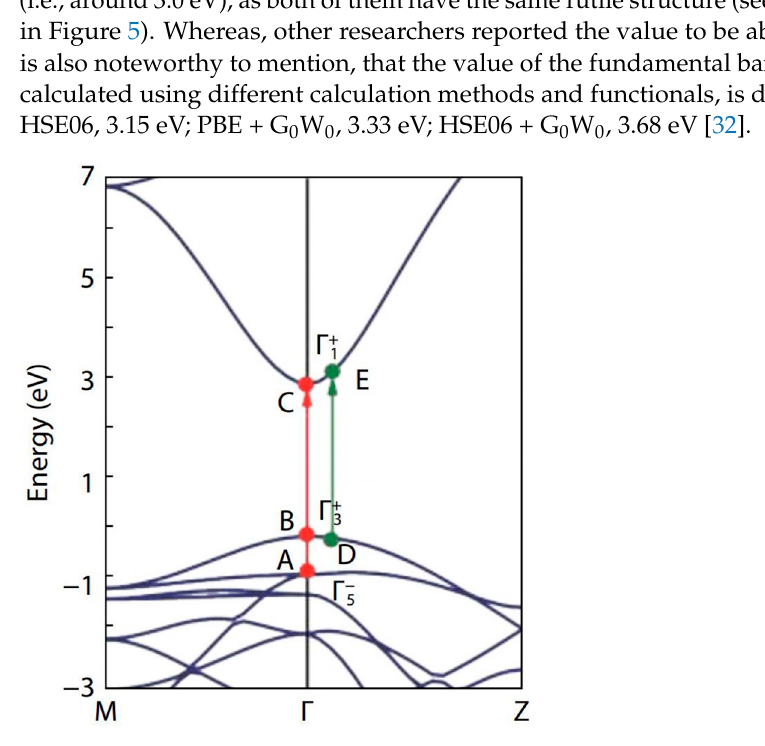
Figure 5. Band structure of SnO 2 along the two high symmetry lines M– Γ –Z. The valence band maximum is set at zero. The red and green arrows represent the possible optical transitions at Γ -point and away from Γ -point, respectively. The figure was reproduced/adapted from the work of Cai et al. (2011) [32].